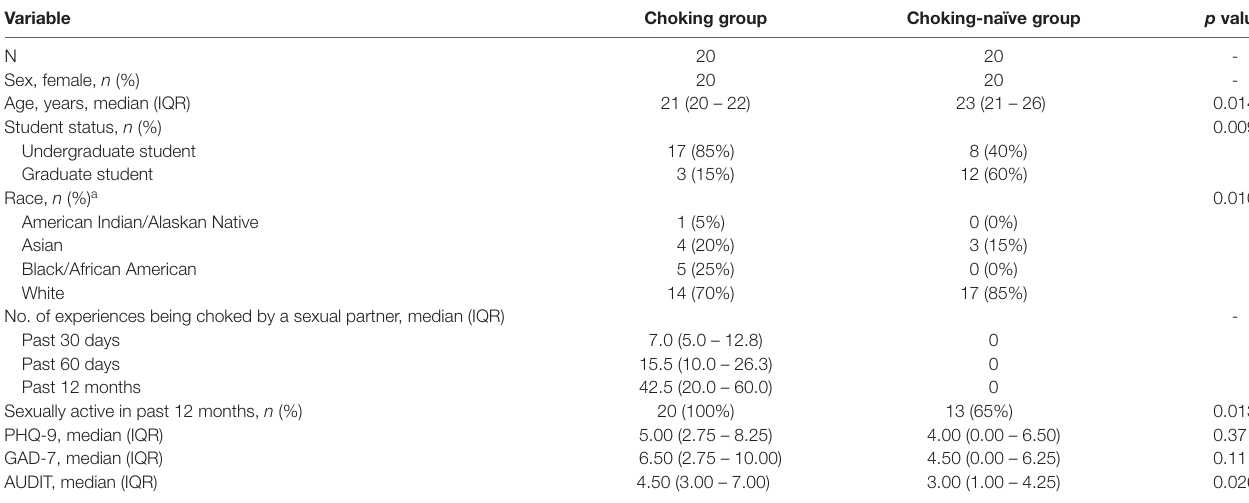
TABLE 1 | Demographic